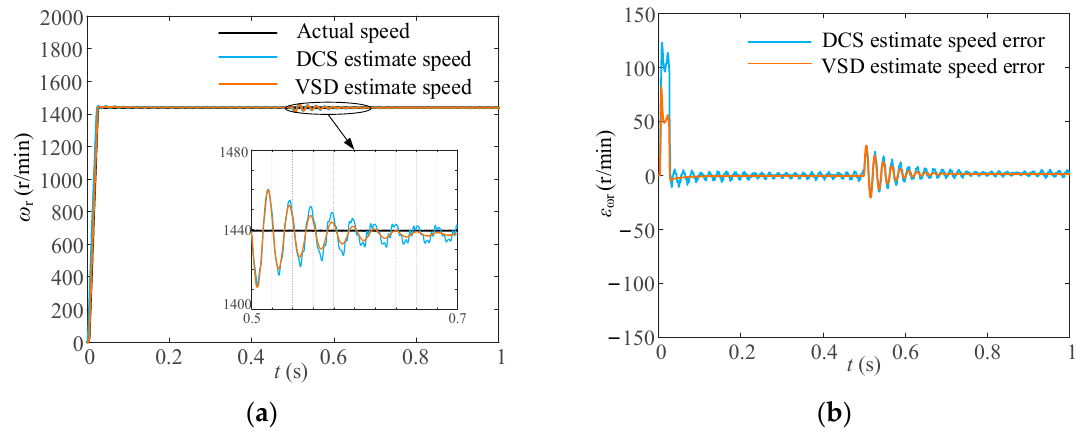
Figure 15. Speed-estimation results without stator resistance identification. ( a ) Speed; ( b ) Speed errors.